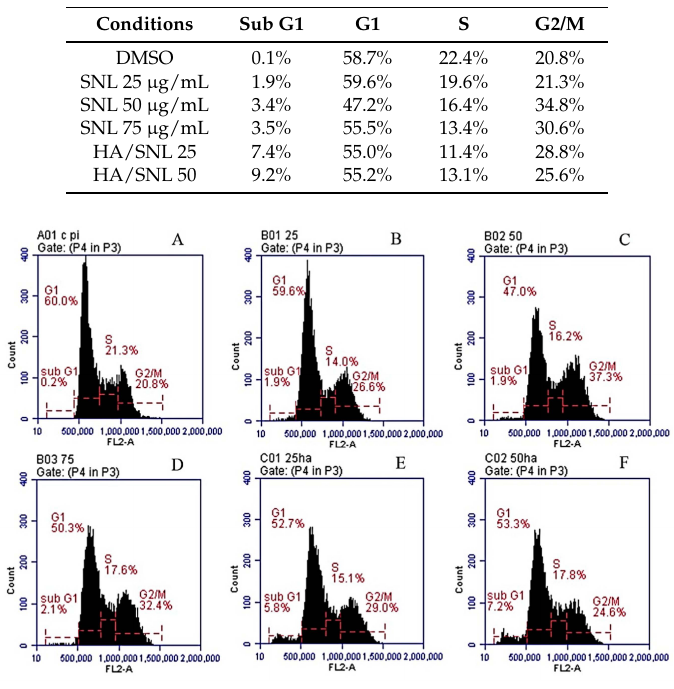
Table 2. Distribution of A549 cell cycles treated with DMSO, SNL, and HA/SNL